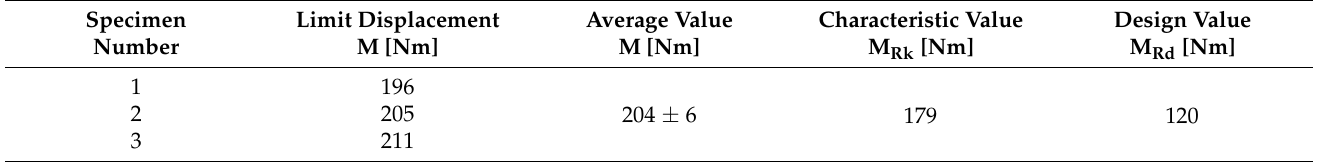
Table 4. Characteristic and design values for closing of the rigid